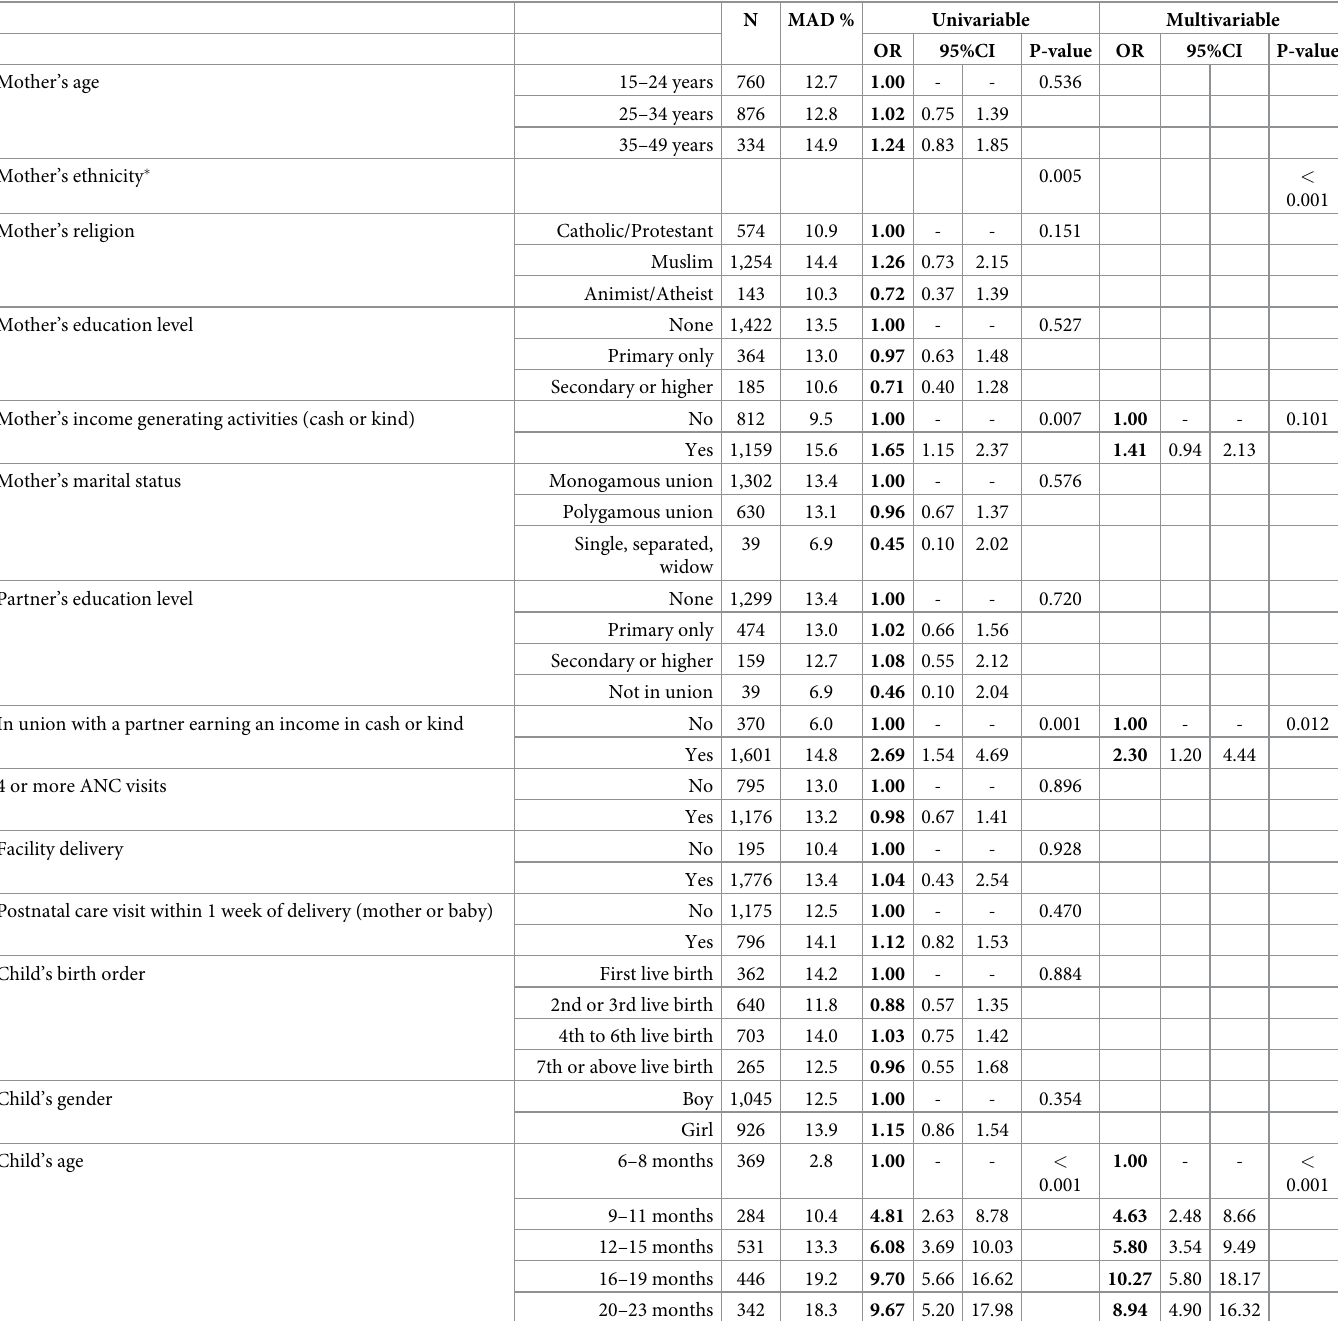
(Table 7, S2–S4 Tables). Other predictors of IYCF practices included: mother’s ethnicity, Table 7. Predictors of minimum acceptable diet (MAD) in children 6 to 23 months of age (N =